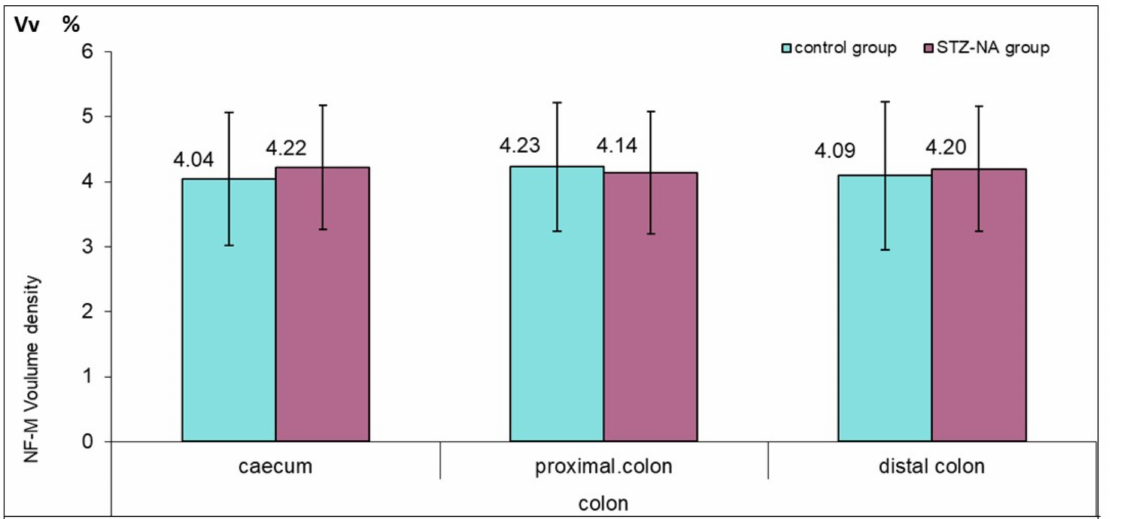
Figure 5. Volume density of NF-M positive fibers in the muscle layer of the rat colon in control and STZ–NA group. Numerical values presented in the figure correspond to the mean values of the NF-M volume